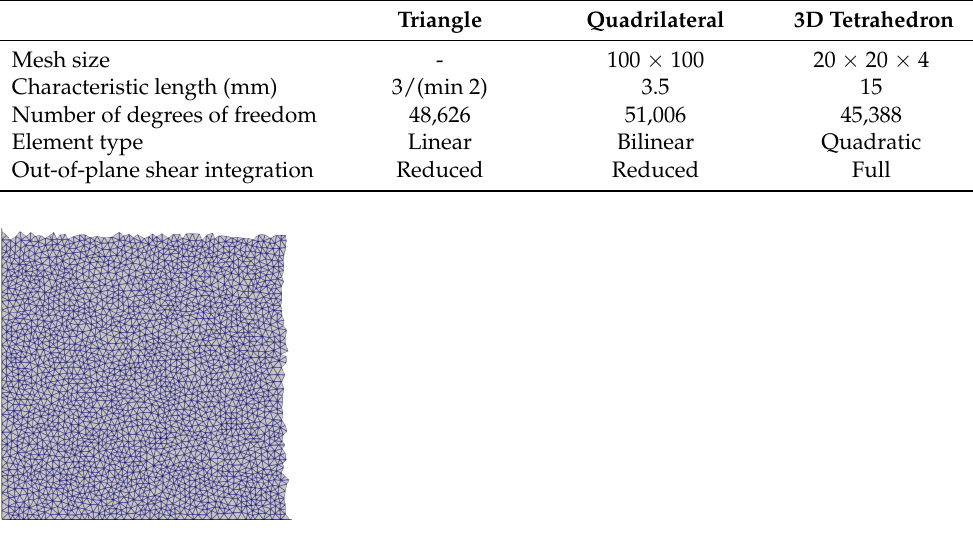
Figure 6. Example of finite element mesh consisting of a random grid of 3-node triangular